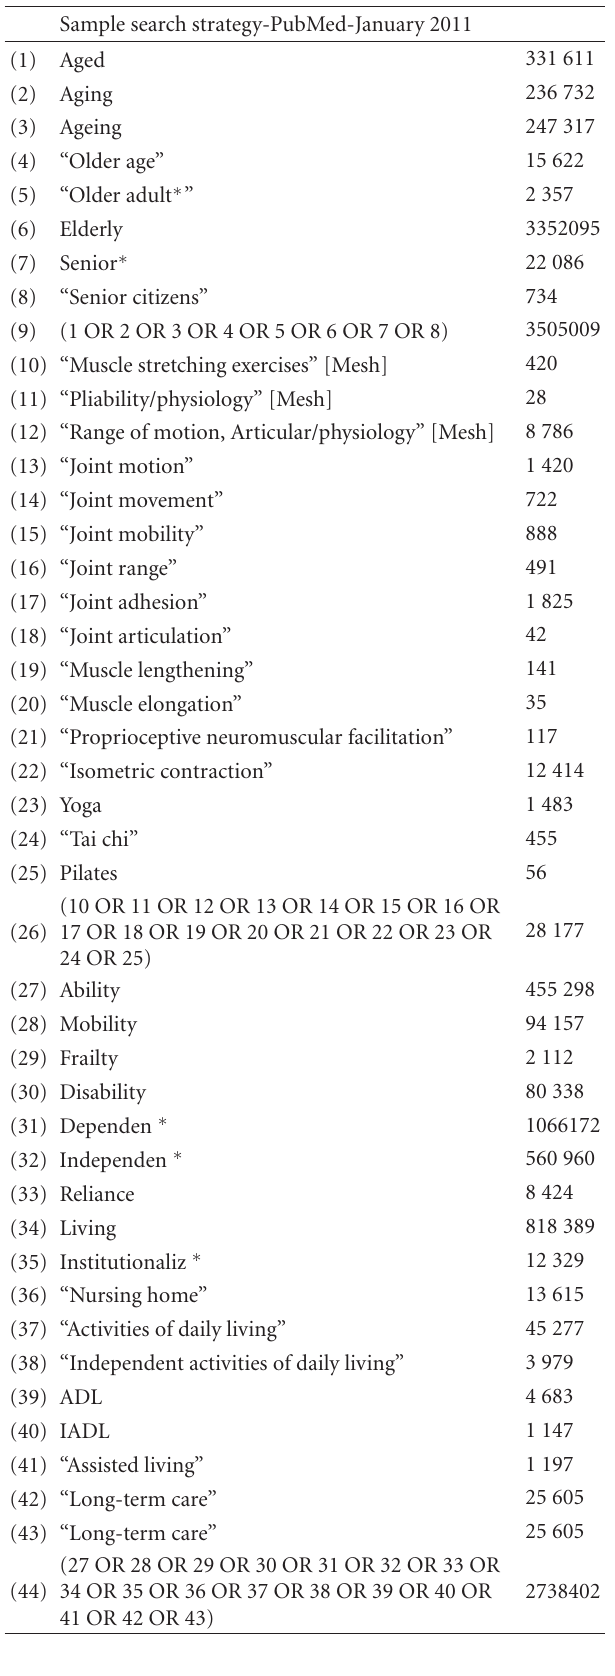
Table 2: Sample electronic database search